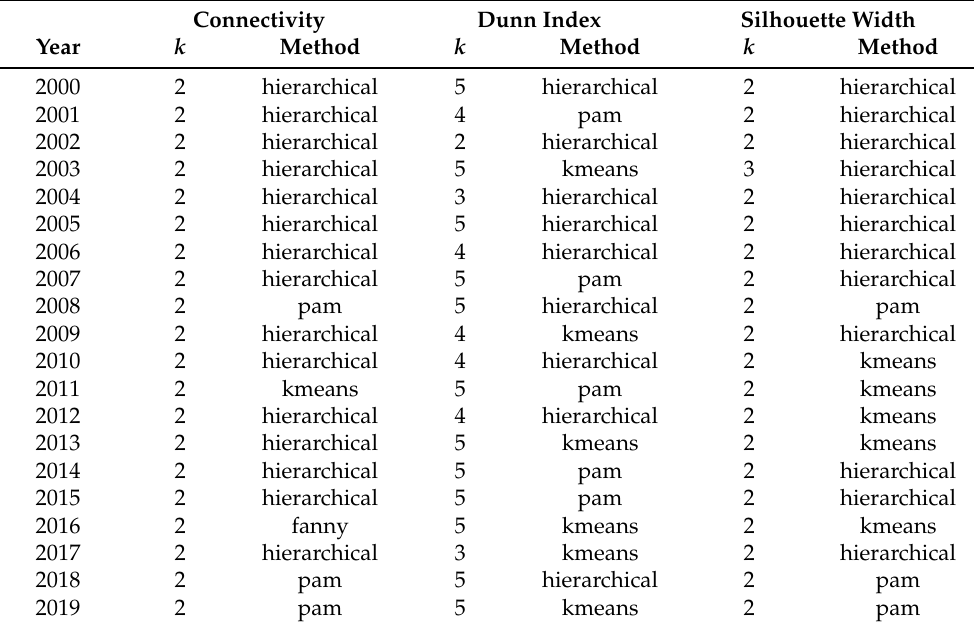
Figure 3. Clusters’ internal validation measures for the year 2019. Table 1. Optimal cluster number ( k ) and method for internal